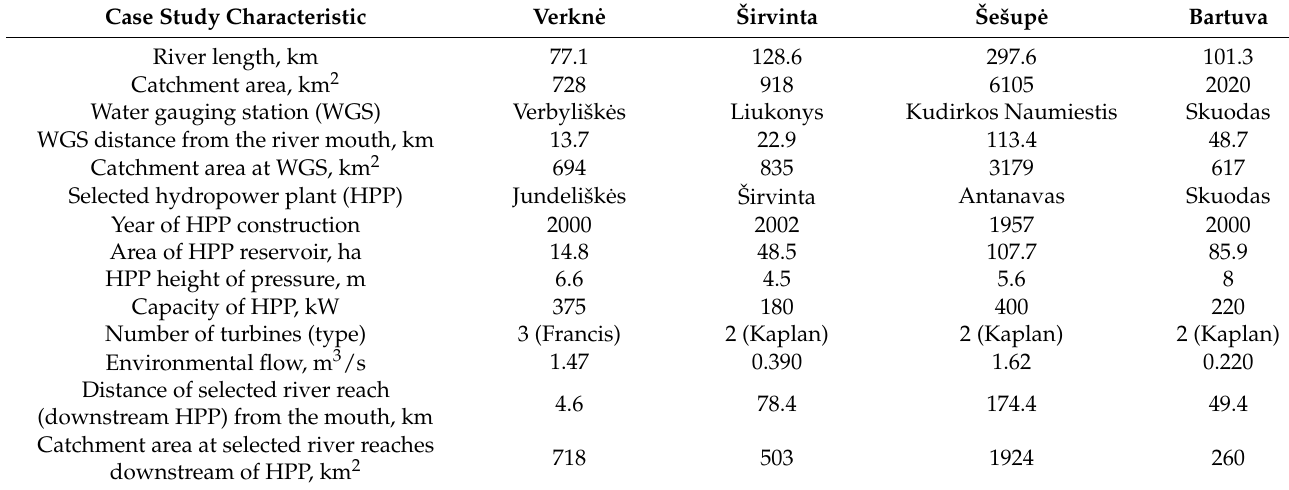
Table 1. River catchments features and hydropower plants characteristics are considered in the